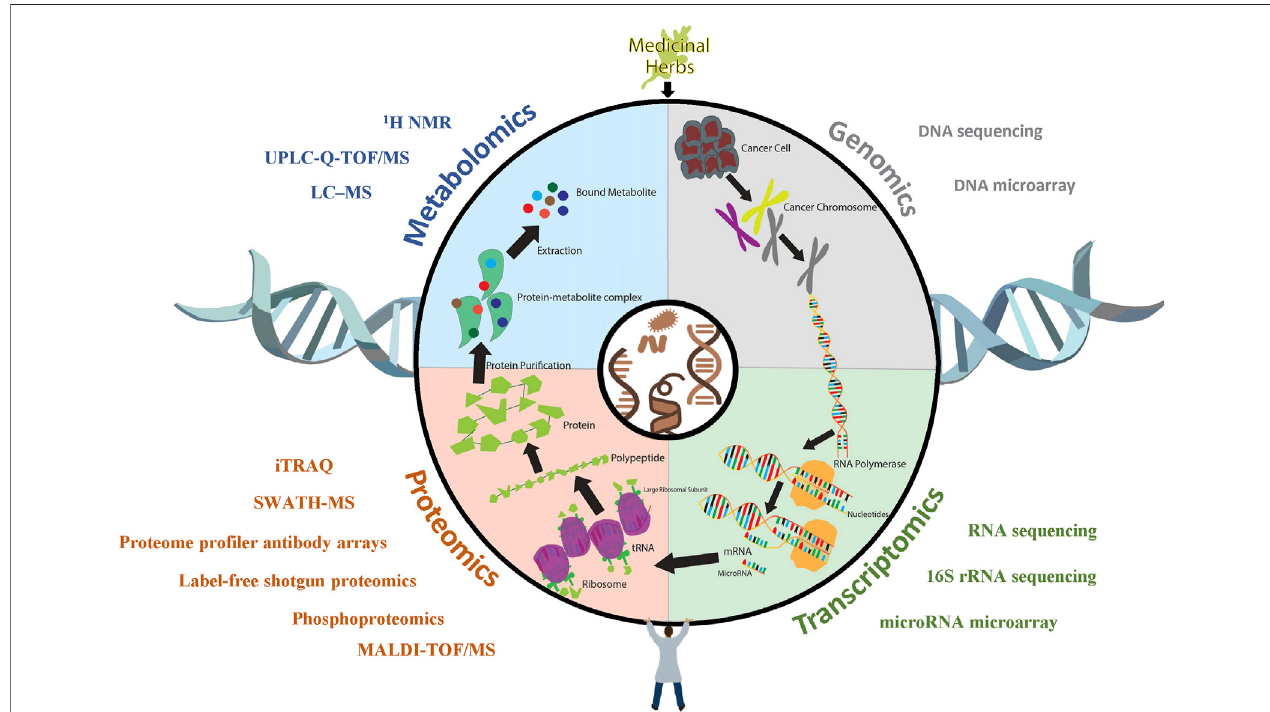
FIGURE1| TheapplicationofOMICStechnologiesinanti-GIcancerresearch.Uponbeingtreatedwithmedicinal herbs,cancercellsundergoaseriesofbiological processes, during which large amounts of molecular alterations are re fl ected in different dimensions, such as protein and mRNA expression levels and metabolite pro fi les.VariousOMICStechnologies,suchassequencing,microarrays,andiTRAQassays,havebeenutilizedtounraveltherespectivealterationsofcancerinresponse to medicinal plants.